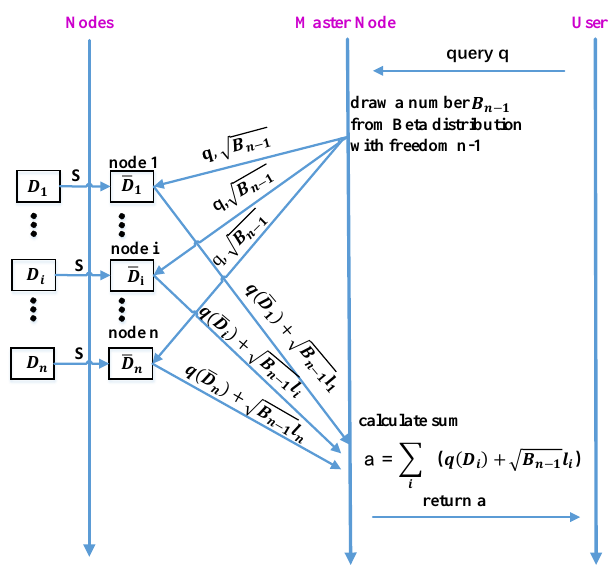
Figure 4. The process of proposed mechanism handles queries from the